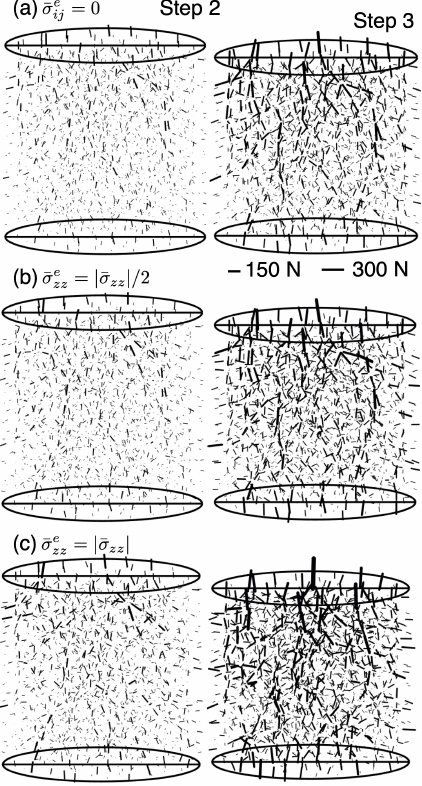
Figure 3. Forces at step 2 (left) and 3 (right) from DEM (a) and inferred with two noise levels in (b) and